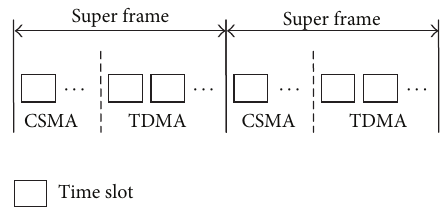
Figure 1: Dynamic routing mechanism without setup period.